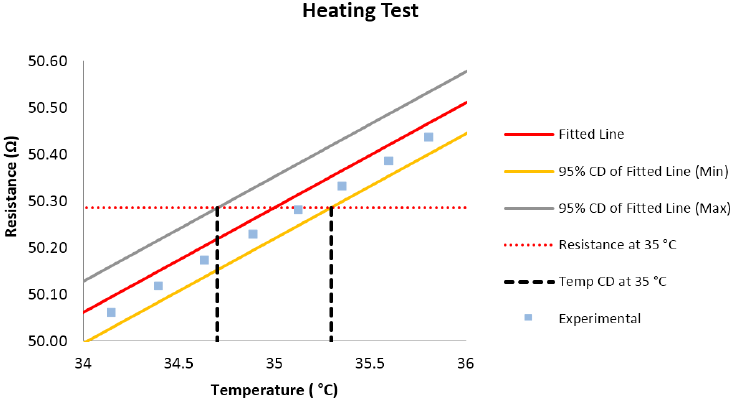
Figure 12. Uncertainty in TR relationship at 35 °C (Heating, N10046S1).